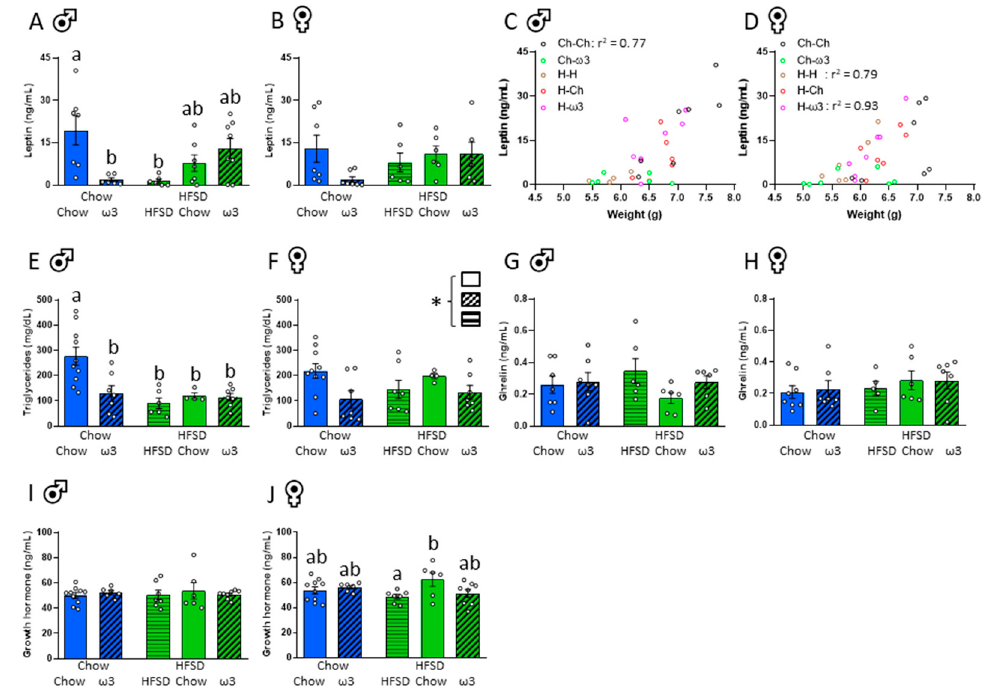
Figure 4. Effects of maternal pre- and post-conception diet on pup circulating leptin and ghrelin. ( A ) Circulating leptin, males. ( B ) Circulating leptin, females. ( C ) Correlation between circulating leptin and weight at postnatal day 1, males. ( D ) Correlation between circulating leptin and weight at postnatal day 1, females. ( E ) Circulating triglycerides, males. ( F ) Circulating triglycerides, females. ( G ) Circulating ghrelin, males. ( H ) Circulating ghrelin, females. ( I ) Circulating growth hormone, males. ( J ) Circulating growth hormone, females. HFSD: high-fat-high-sugar diet; Ch: chow (in C and D ). Letters denote post hoc differences between groups; * significant effect of post-conception diet ( p < 0.05). Data are mean ± SEM ( n = 6–10). Each data point represents one pup per litter per sex.